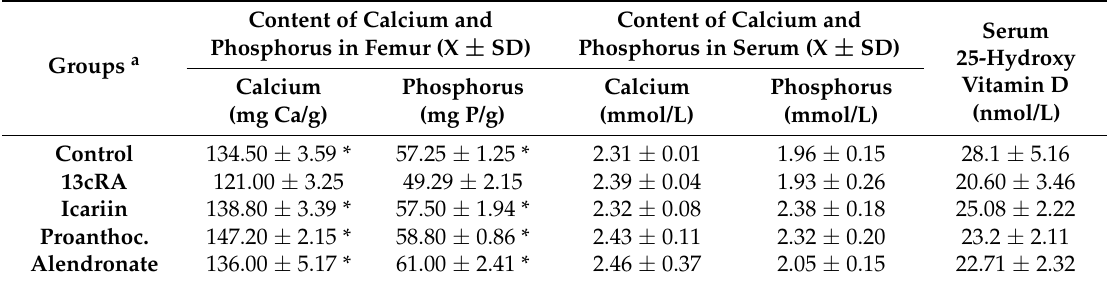
Table 5. Effect of icariin, proanthocyanidins or alendronate on content of calcium, phosphorus and vitamin D in femur and in serum in rats with retinoic acid-induced bone loss. Groups a